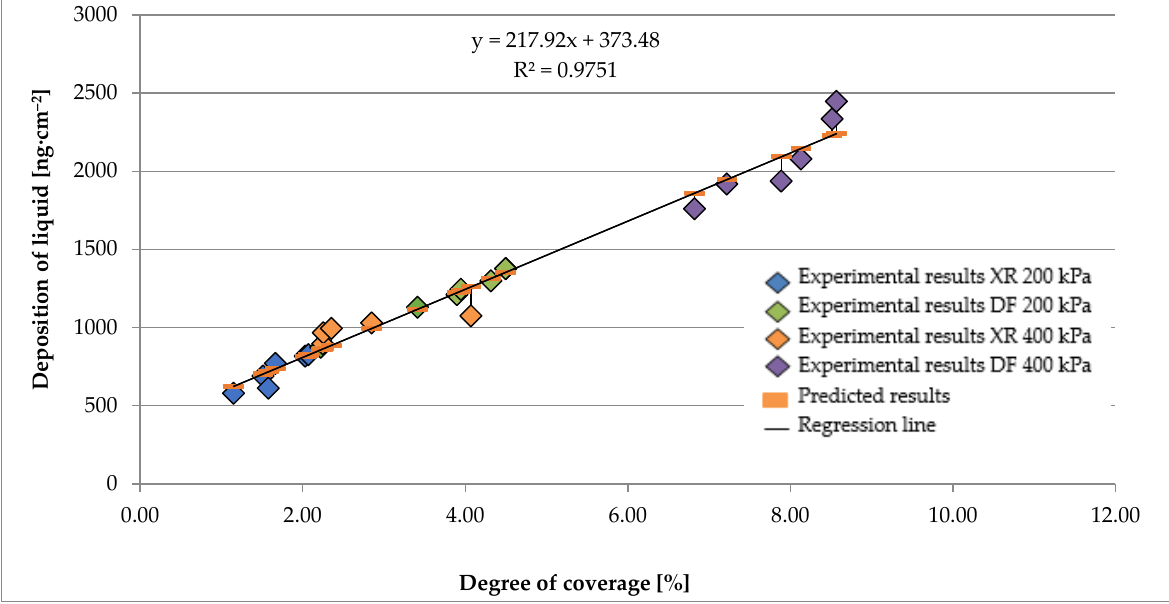
Figure 6. The scatter plot of the degree of coverage and deposition of spray liquid for selected stand- ard nozzles for leaving the vertical surface.